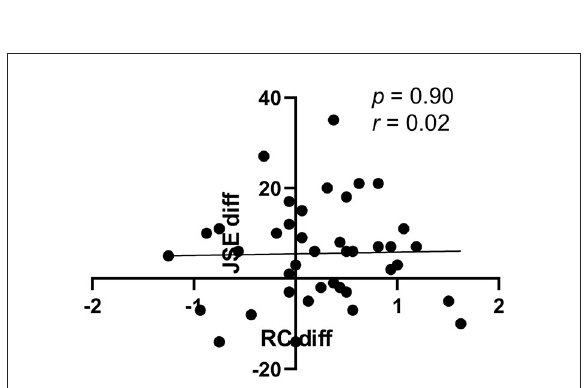
FIGURE6 Correlation between individual changes in JSE and RC scores of students in CO. Each CO student’s change in their JSE score between August and December is shown on the Y-axis (Jeff diff), while the change in the same student’s RC score (RC diff) is plotted on the x-axis ( n = 40).